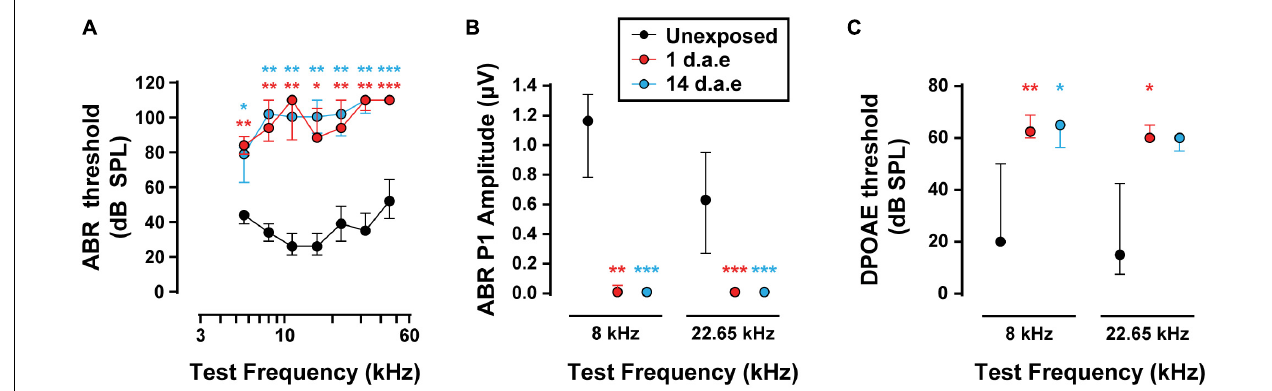
FIGURE 1 | Exposure to 120 dB sound pressure level (SPL) noise at P15 induces a severe reduction in hearing sensitivity in P16-17 mice. (A) Auditory Brainstem Responses (ABR) thresholds for P16-17 control (Unexposed), P16-17 1 day after exposure (1 d.a.e.) and P29-30 14 days after exposure (14 d.a.e.) mice. (B) ABR wave-I baseline to peak amplitudes at 80 dB SPL for 8 and 22.65 kHz. (C) Distortion Product Otoacoustic Emission (DPOAE) thresholds in the same experimental groups for 8 and 22.65 kHz. Noise exposure triggers an elevation of cochlear thresholds which lasts for at least 14 days. In all cases, median ± interquartile ranges (IQRs) are shown, and the comparisons were made by Kruskal-Wallis non-parametric ANOVA followed by Dunn’s post-test (* p < 0.05, ** p < 0.01, *** p <